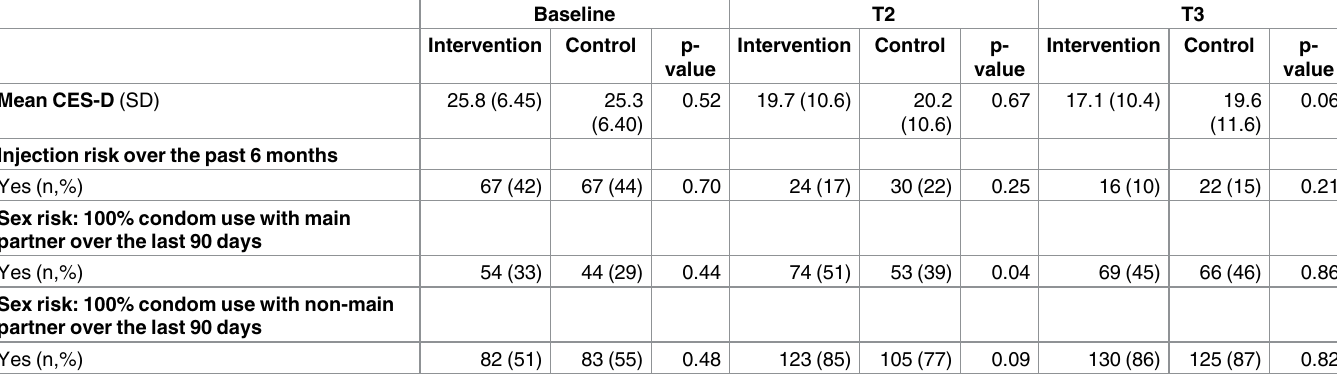
Table 2. Changes in outcomes by arm at baseline, 6 and 12 month follow-up, the Workshop study, Baltimore Maryland.